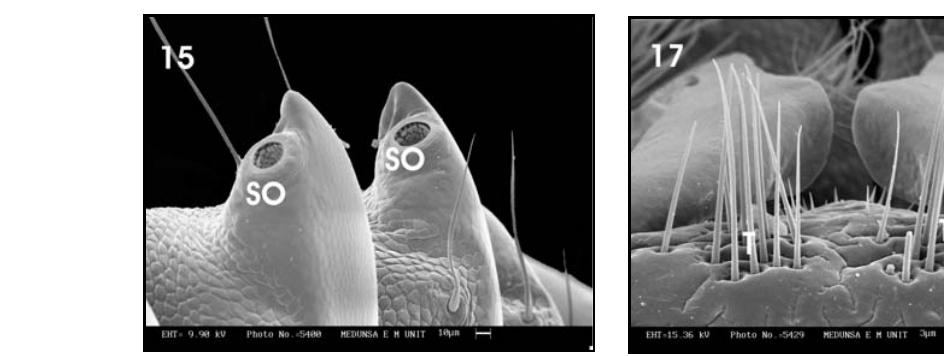
Fig. 17. Two small tufts (T) of setae were situated to the anterior base of the